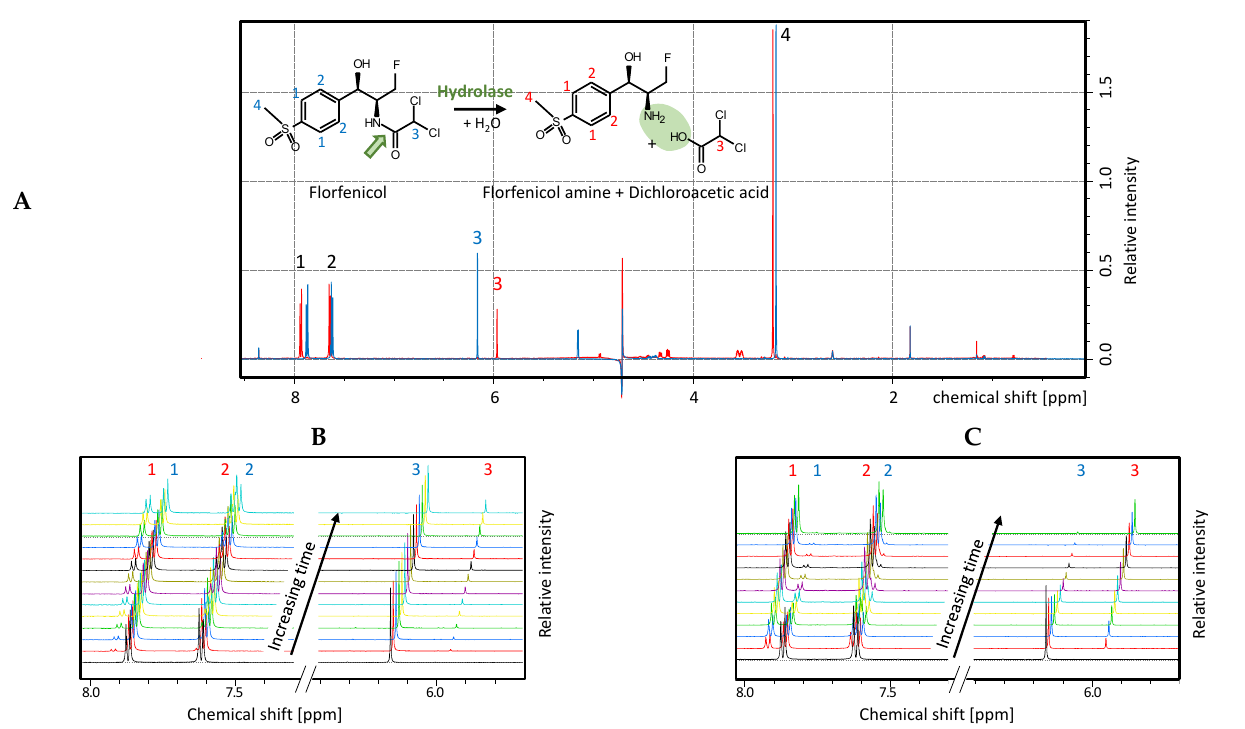
Figure 5. Florfenicol cleavage visualized by NMR spectroscopy. ( A ) Chemical reaction scheme of florfenicol cleavage and corresponding 1 H-NMR spectrum before (blue) and after (red) addition of hydrolase. The assignment of the NMR signals to the corresponding protons in the chemical structural formula is indicated by numbers; ( B , C ) excerpts from the NMR spectra recorded every 4 min (colored lines) after addition of ( B ) wild-type hydrolase EstDL136 and ( C ) mutant 36P5 to florfenicol.